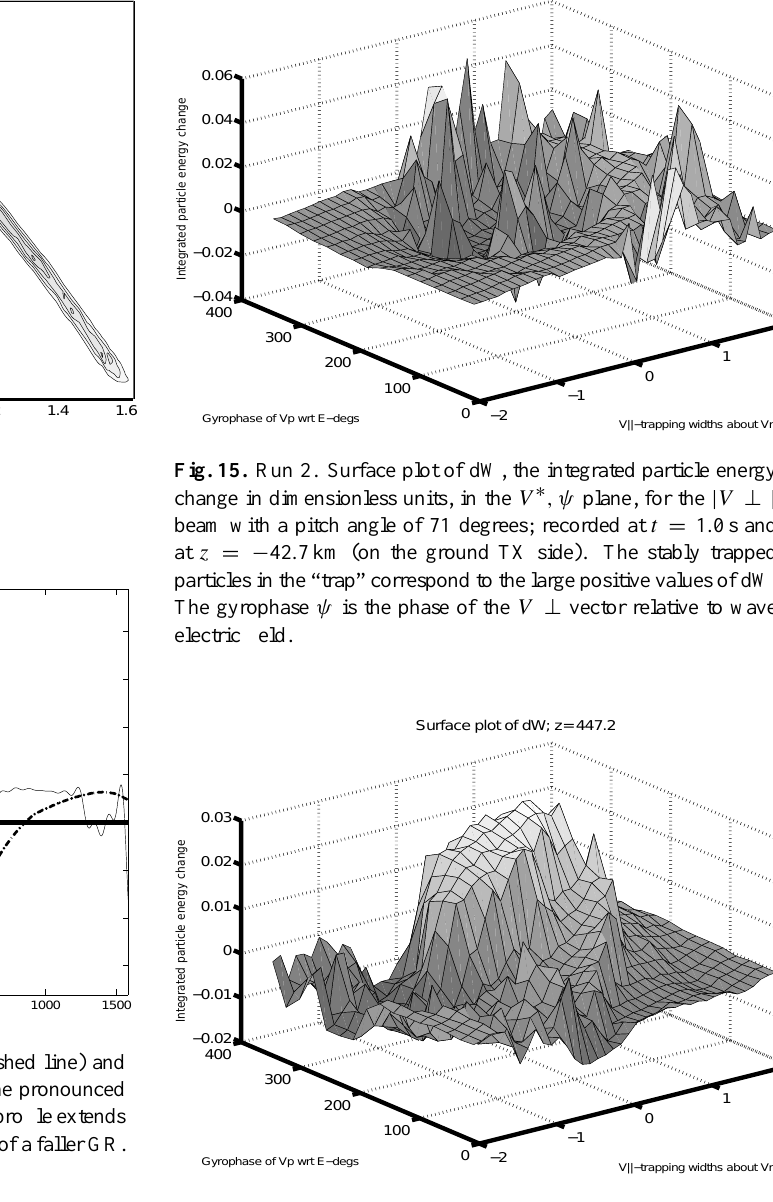
Fig. 16. Run 2. Surface plot of dW, but at z = 447 .